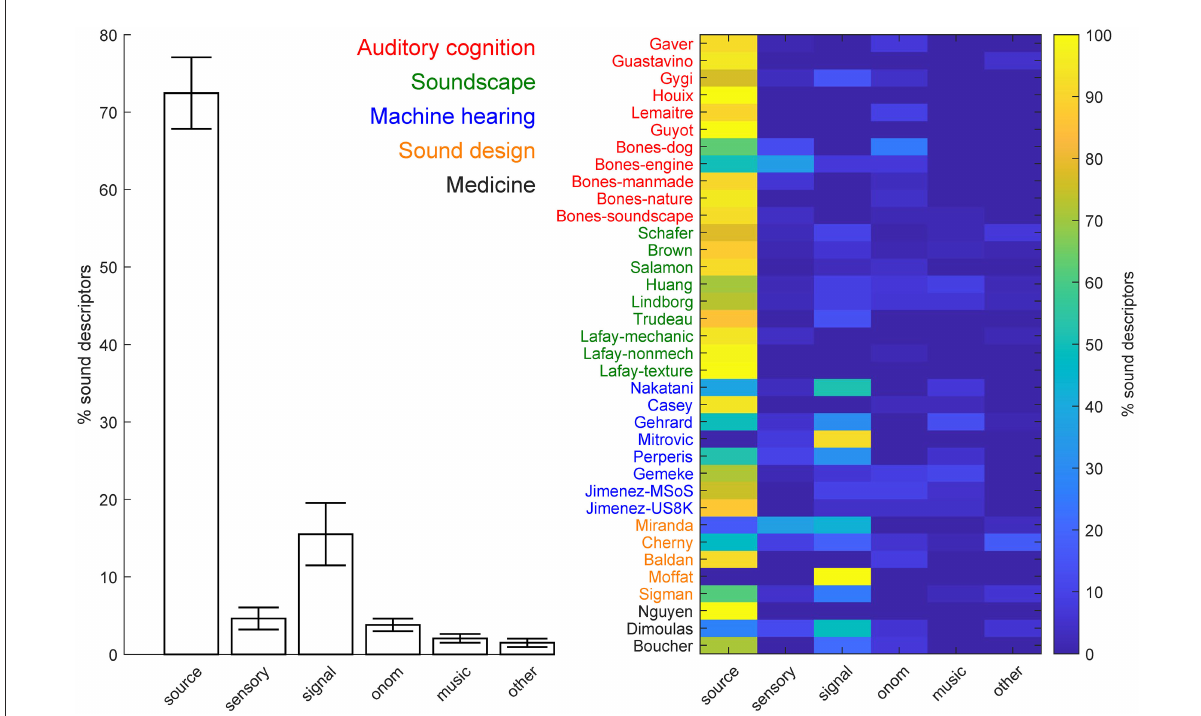
FIGURE4 Percentage of sound descriptors in each of the five main categories, including the generic descriptors. Left = average % across knowledge organization systems (error-bar = ± 1